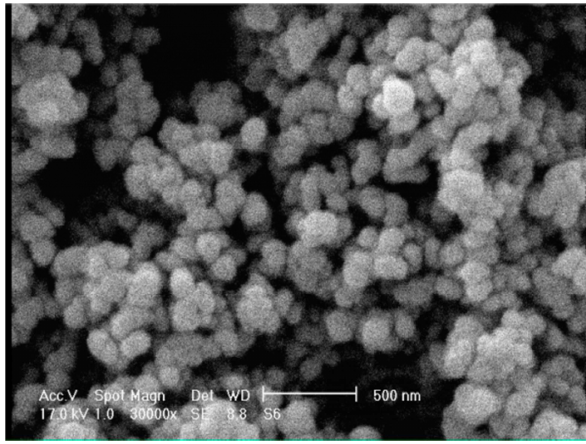
Figure 3. Scanning electron microscope (SEM) micrograph of ZnO nanoparticles fixed on glass with a magnitude of 30000